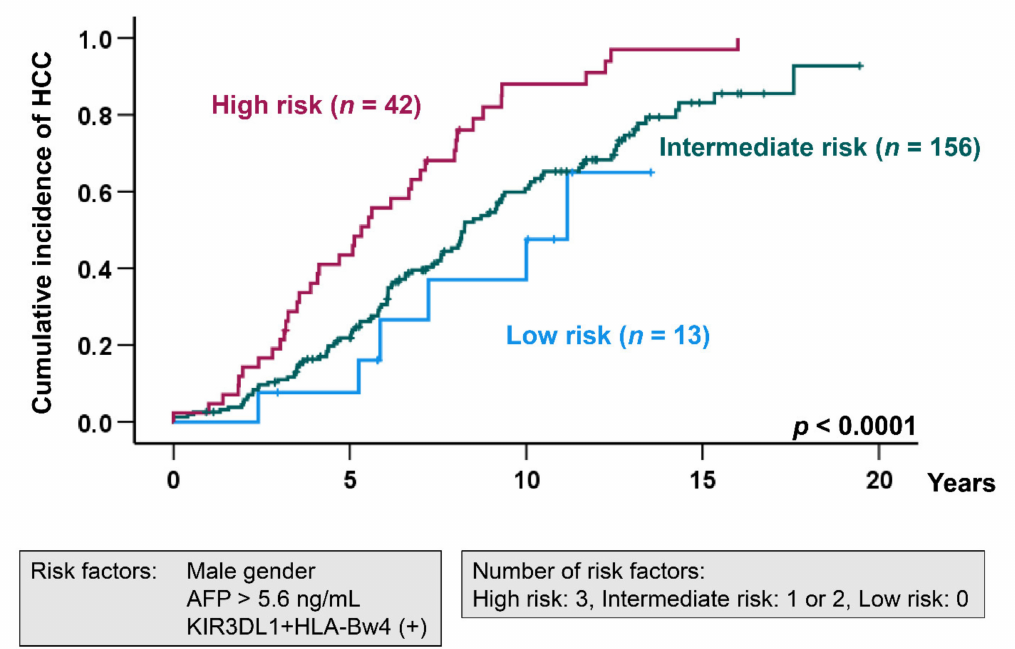
Figure 2. Cumulative incidence of HCC in HCV-induced cirrhotic patients according to the number of the risk factors (male gender, AFP > 5.6 ng/mL, and KIR3DL1 + HLA-Bw4). p -value was calculated by the log-rank test. AFP: α